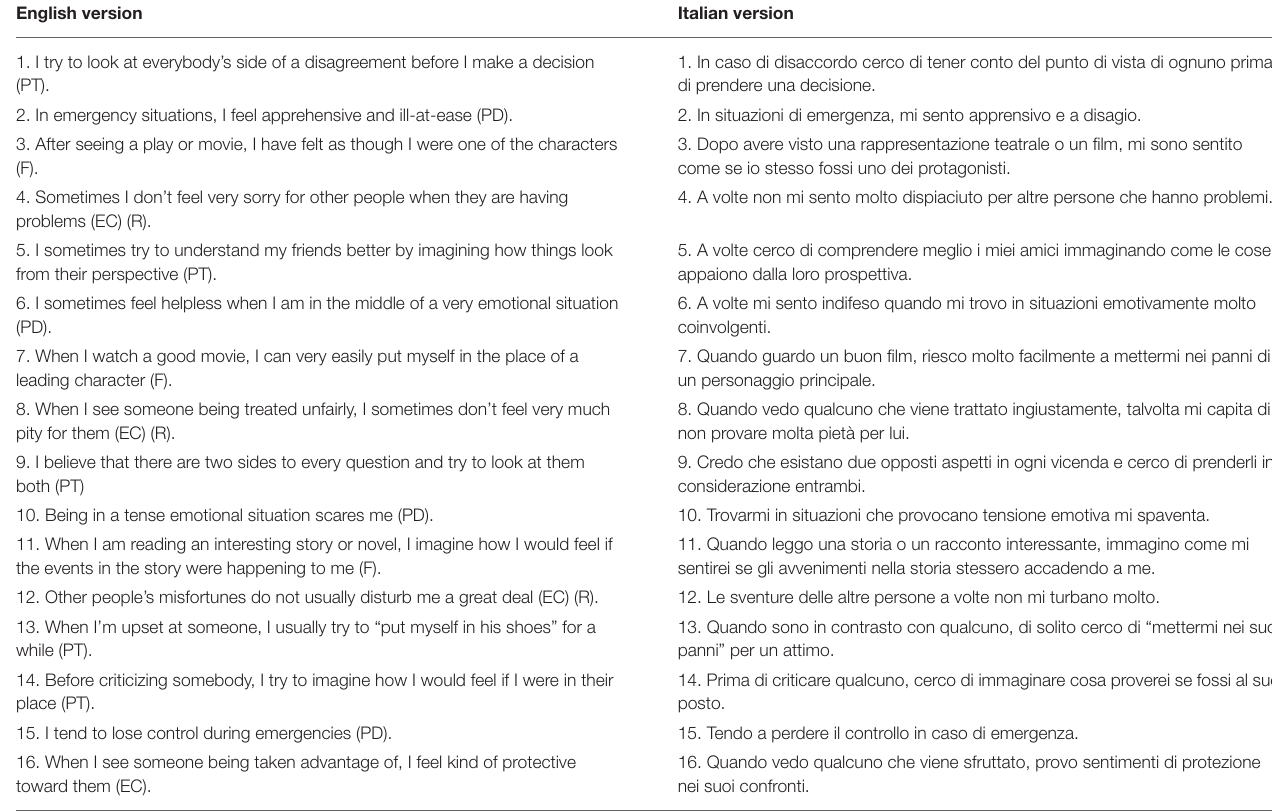
TABLE 9 | Interpersonal reactivity index - brief